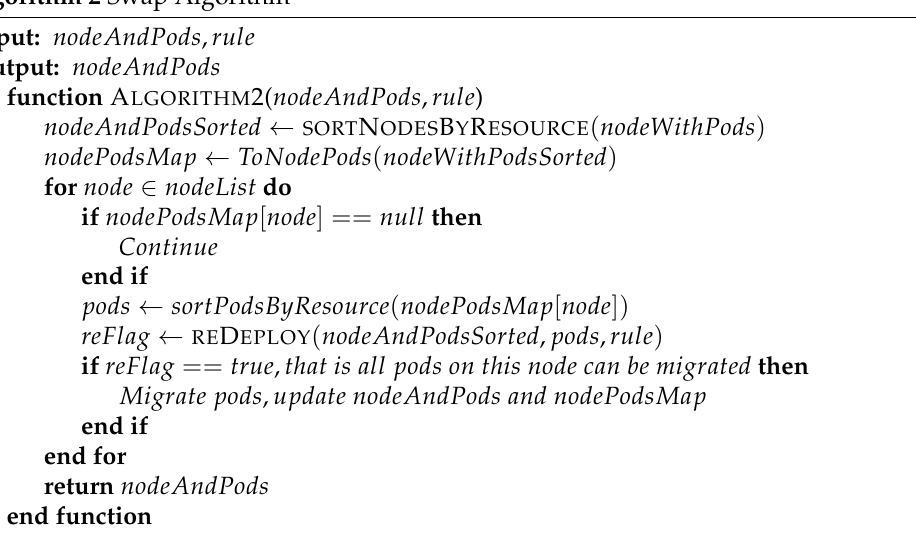
Algorithm 2 Swap